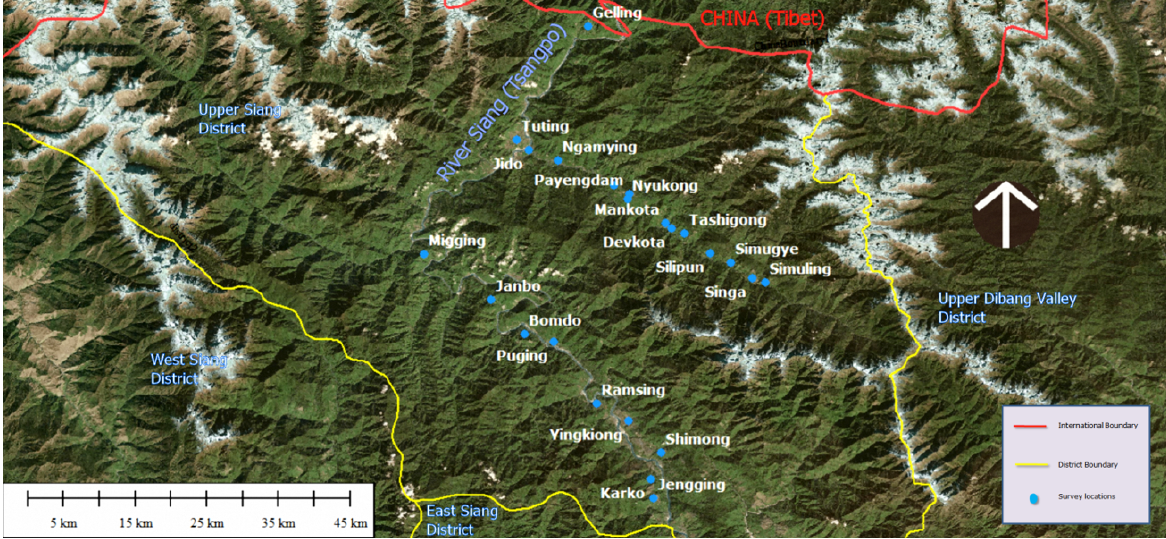
Figure 2. Map showing the locations of various survey sites within the district of Upper Siang. Survey sites are the names of villages but sampling included areas between two adjacent villages as well. The base layer satellite imagery is sourced from the freely available ‘World Imagery’ tiles provided by